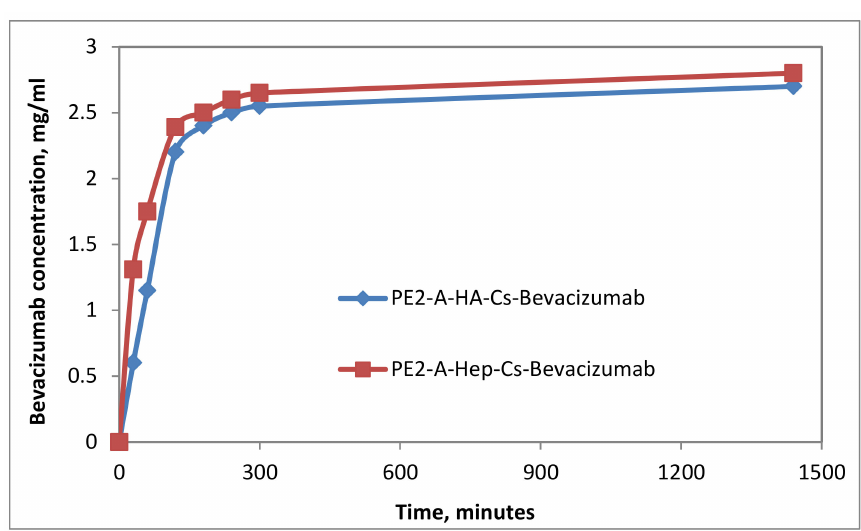
Figure 7. Kinetic curves of dexamethasone release from particulate systems.